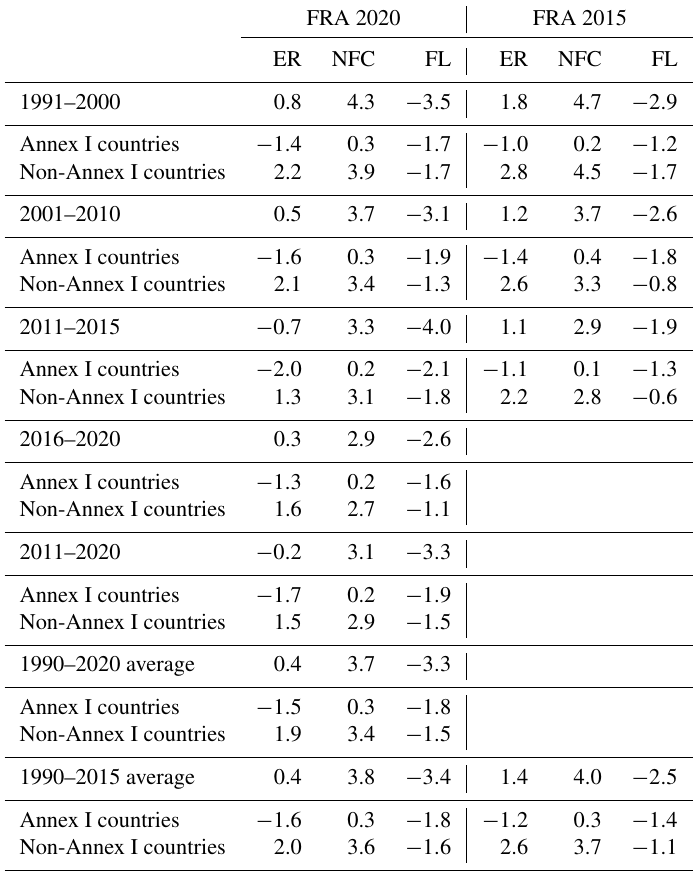
Table 1. Estimates of total emissions and removals from forests (ER), net forest conversion (NFC) and emissions/removals on forest land (FL) for world, Annex I and non-Annex I totals, based on FRA 2020 and FRA 2015 (GtCO 2 yr − 1 ).